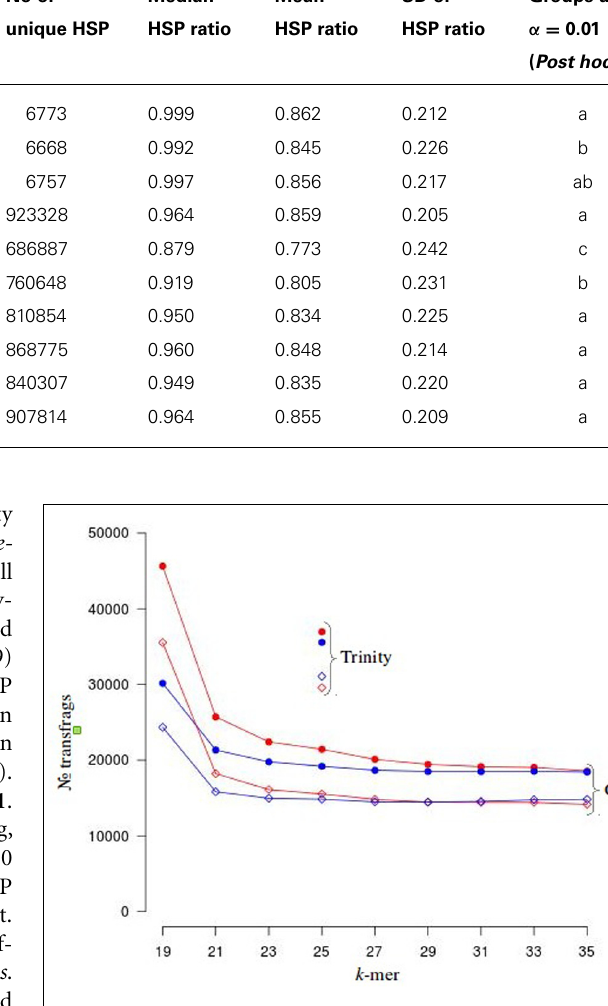
FIGURE 1 | Distribution of unique (solid circles) and overlapping (diamond shaped) transfrags (TF) from Neurospora crassa. TF from untrimmed and trimmed reads that map to common a genomic loci can be considered as overlapping. Below k -23, there is considerable difference in the number of unique and overlappingTF between the trimmed and untrimmed categories.TF from untrimmed and trimmed reads are represented in red and blue,